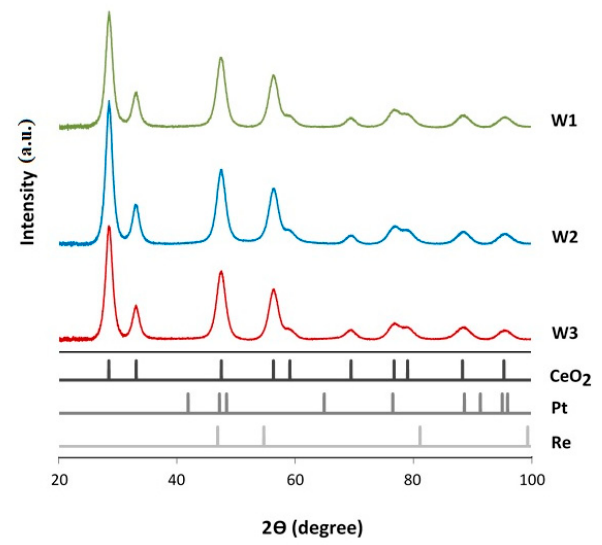
Figure 1. Diffractograms of powder catalysts: W1, W2 and W3.